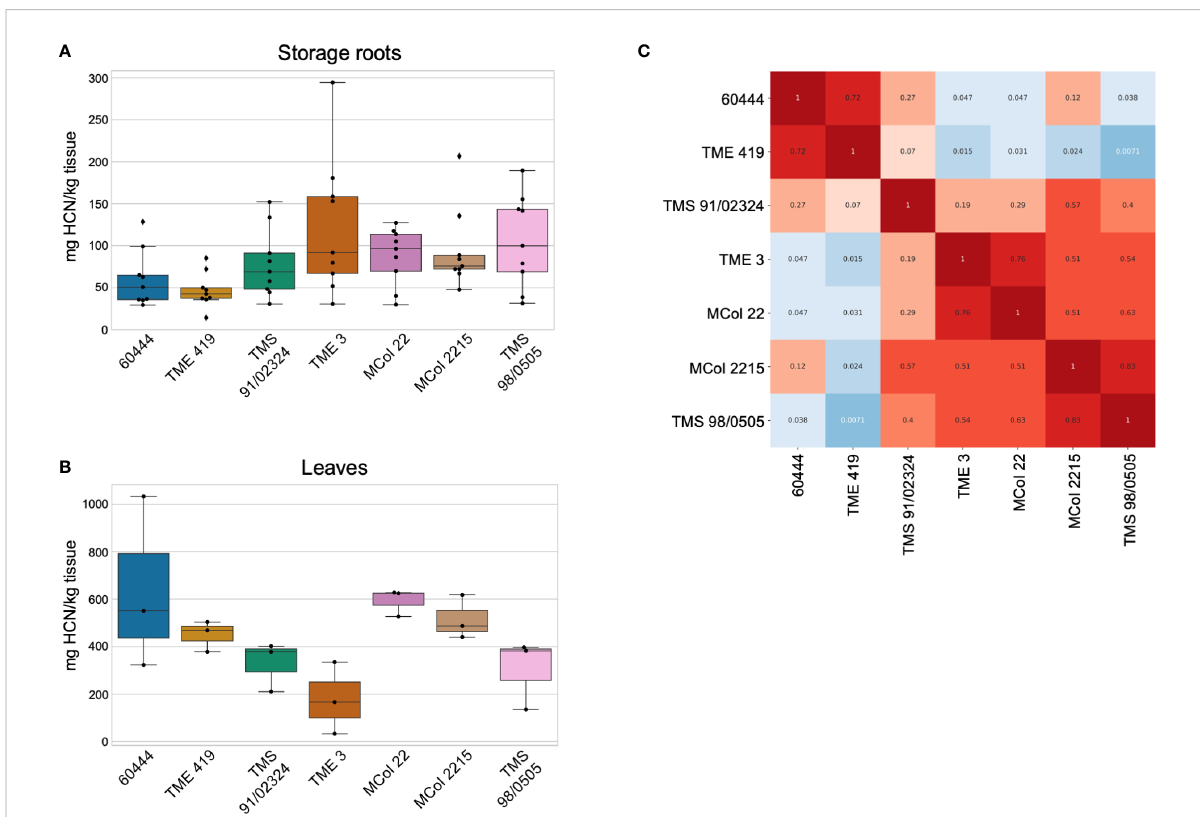
FIGURE 3 Cyanide levels from seven transformable cassava accessions. Assays were conducted seven months after plants were transferred to soil. (A, B) Cyanide levels in (A) storage roots and (B) leaves of the indicated cassava accessions in mg HCN per kg tissue, as detected by picrate assay. Black dots are assayed values. The median, upper, and lower quartiles are indicated. Whiskers de fi ne the minimum and maximum regions, and dots outside of these are outliers. (A) Root measurements. For each accession, samples were taken from a total of nine tuberous roots, from four to six plants. (B) Cyanide measured from leaf samples. For each accession, a total of three leaf samples were taken, from three plants. (C) Wilcoxon Rank Sum p-values calculated from pairwise comparisons between accessions of root cyanide content. Values less than 0.05, indicating the distributions of the values are statistically different between the two lines, are colored in shades of blue. Values greater than 0.05 are colored in shades of